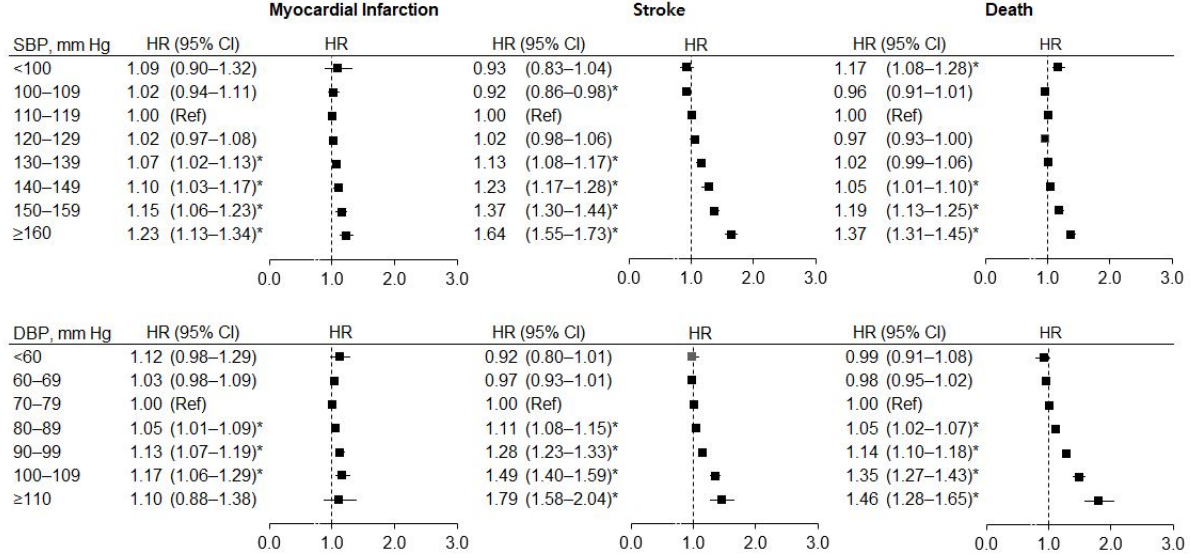
Figure 1. Hazard ratios for incidence of myocardial infarction, stroke, and death according to blood pressure in the total study population. Hazard ratios were adjusted for sex, BMI, smoking, hemoglobin level, alcohol drinking, regular exercise, income, antihypertensive drug use, diabetes, chronic kidney disease, and chronic pulmonary obstructive disease. Error bars indicate 95% confi- dence intervals. Asterisks indicate statistically significant values. SBP, systolic blood pressure; DBP, diastolic blood pressure; HR, hazard ratio; CI, confidence interval; Ref, reference.